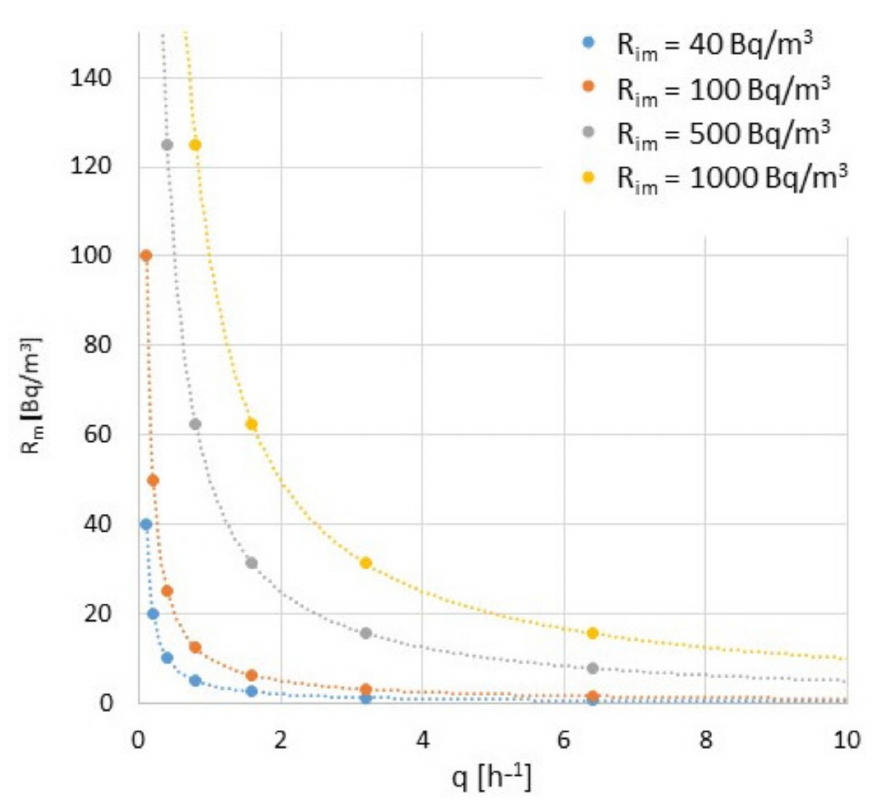
Figure 3. Radon contribution to the indoor-air radon concentration from indoor materials (R m ) described by the function F where the contribution declines by 50% every time the ventilation rate doubles, taking its starting contribution as the initial contribution (R im ) at an air-change rate q of 0.1 times per